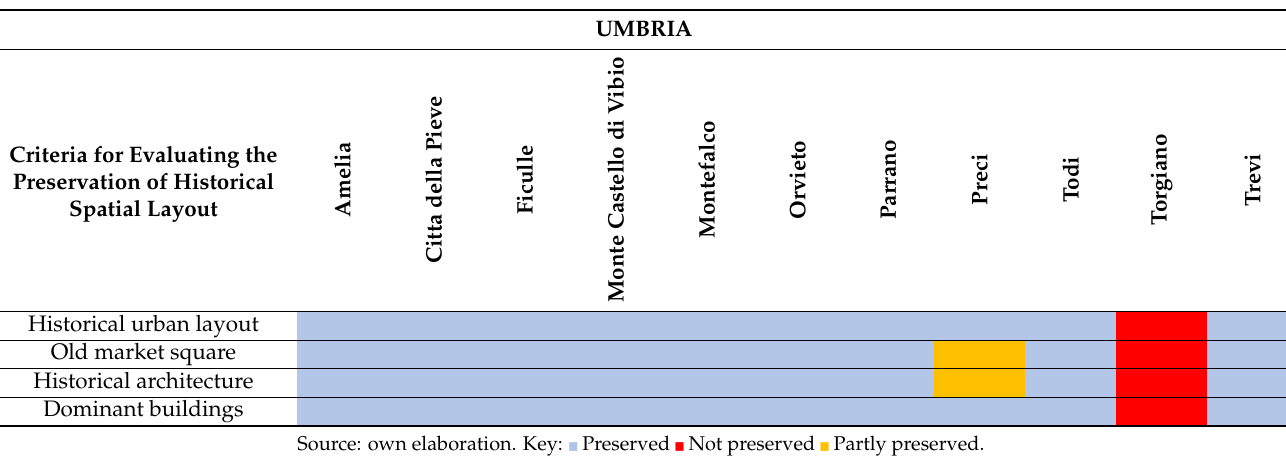
Table 14. Preservation of historical spatial components in Umbrian towns.